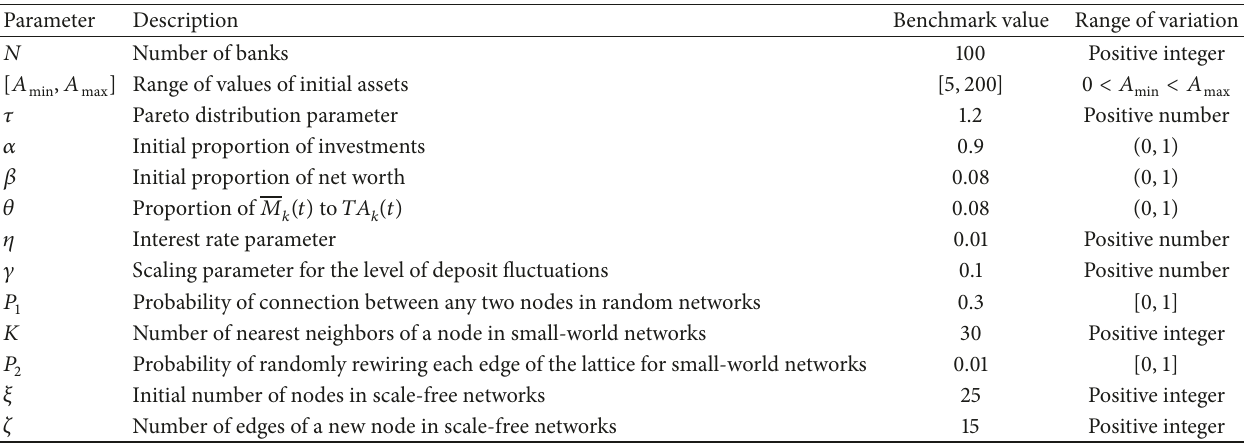
Table 1: Benchmark parameters of the